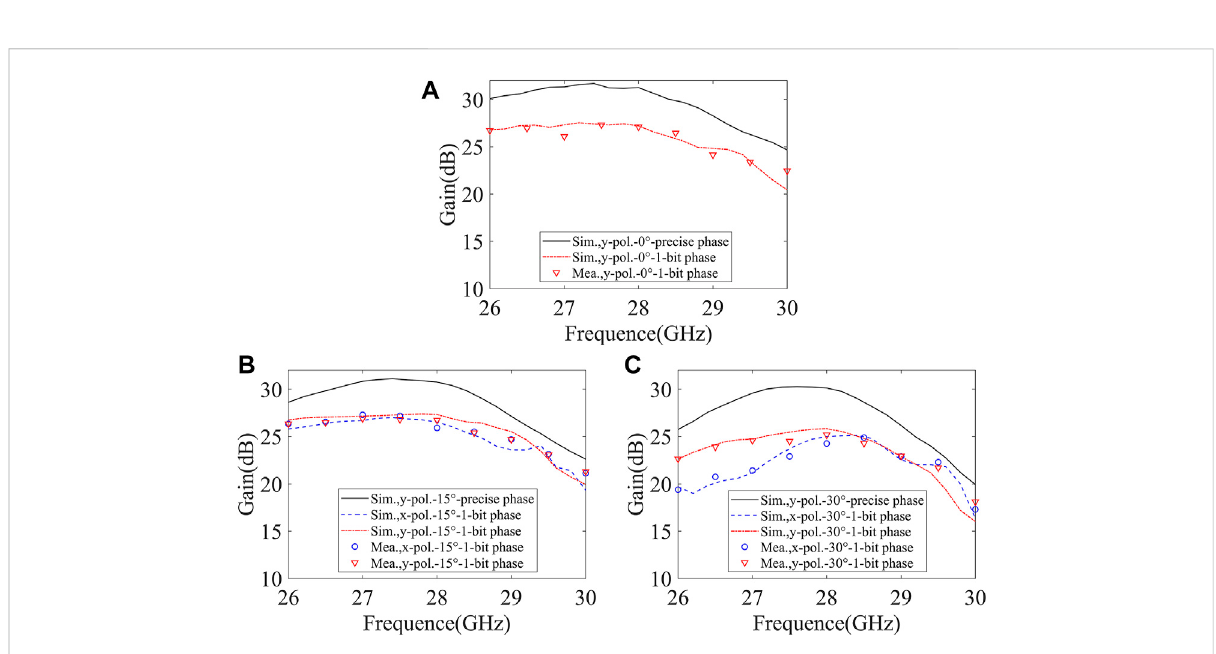
FIGURE 7 (A – C) The gain spectrum for refraction angles of (A) 0 ° , (B) 15 ° , and (C) 30 ° . All cases are compared to the exact phase compensation